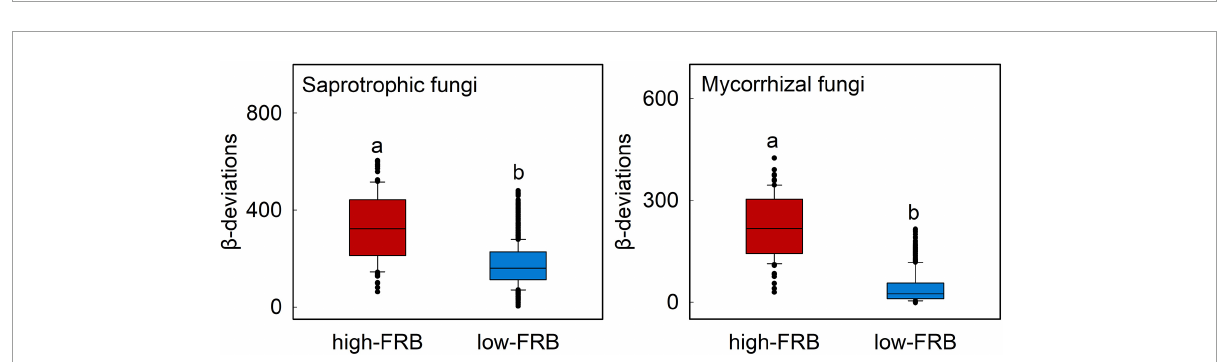
FIGURE5 Variations in β -deviations of mycorrhizal and saprotrophic fungi across low and high categories of fine-root biomass (FRB) in subsurface soil. FRB was separated into two categories and correlated with β -deviations within each category. Boxplots that do not share a lower case letter are significantly different ( P < 0.05, Wilcoxon rank-sum test). These two categories were divided based on Supplementary Figure 4